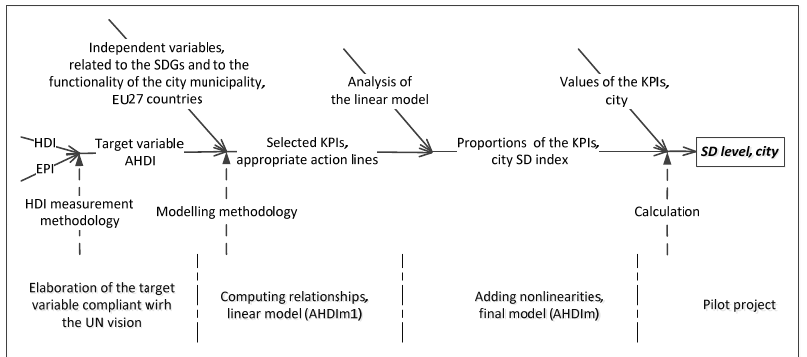
Figure 1. Creation of SD model; methodology. Developed by authors. The modelled AHDI (AHDIm) was defined as a multi-parameter function (f) of the set ( Π ) of n KPIs (p n ):